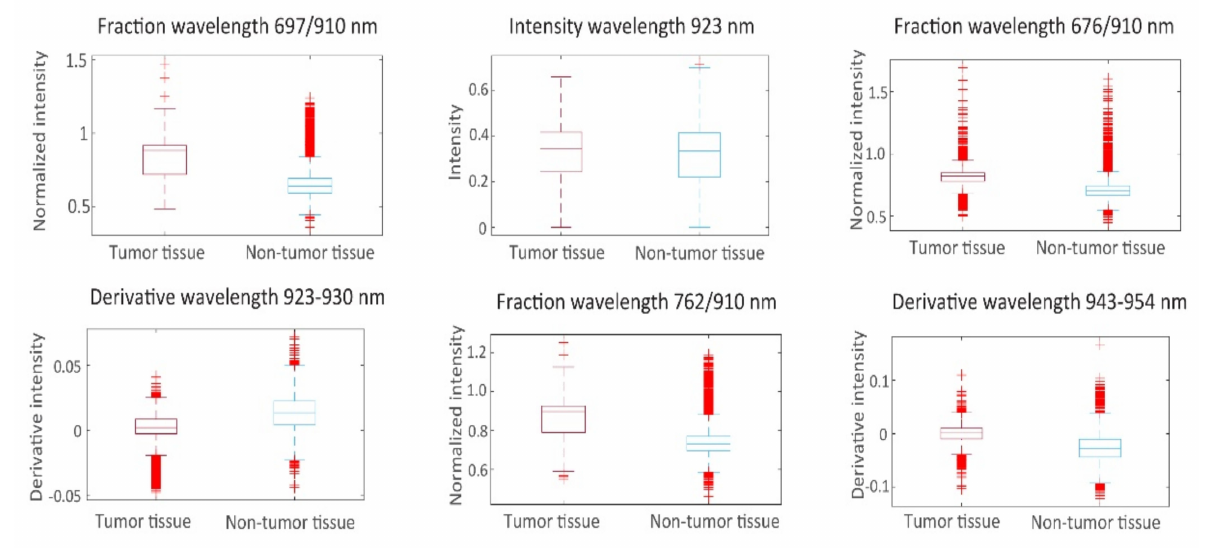
Figure 6. Boxplots of the first 6 principal components of prognostic spectrum features.